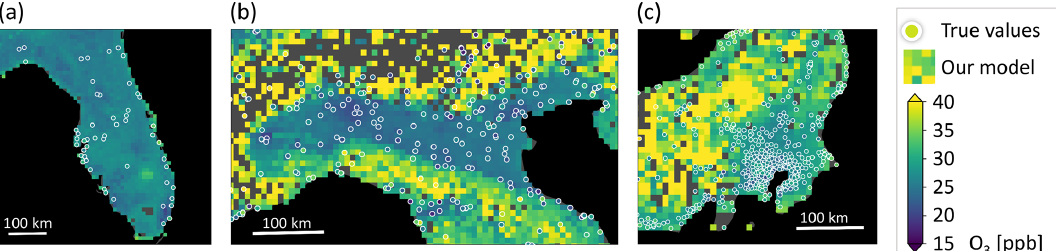
Figure 10. Map details with true values are given as white circles. (a) The Florida peninsula, USA. (b) The Po Valley in northern Italy. (c) Tokyo, Japan, and its